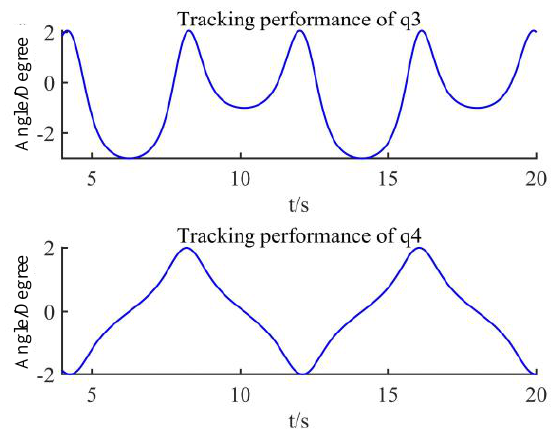
Figure 4. Joint’s control torque.